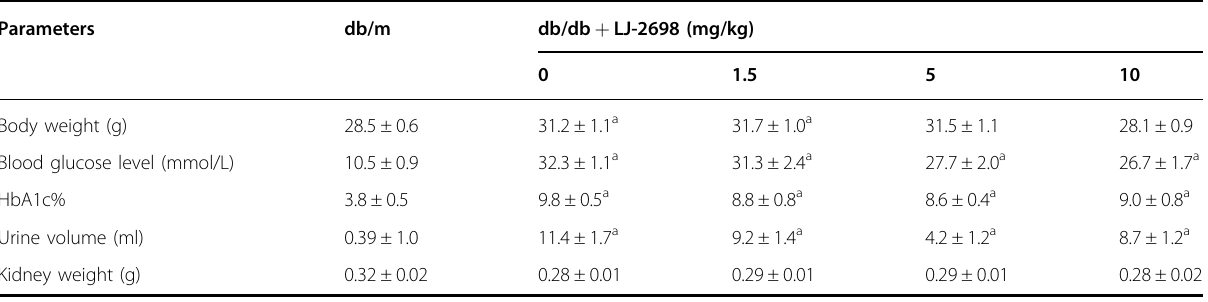
Table 2 Physical and biochemical parameters of experimental animals in experiment I